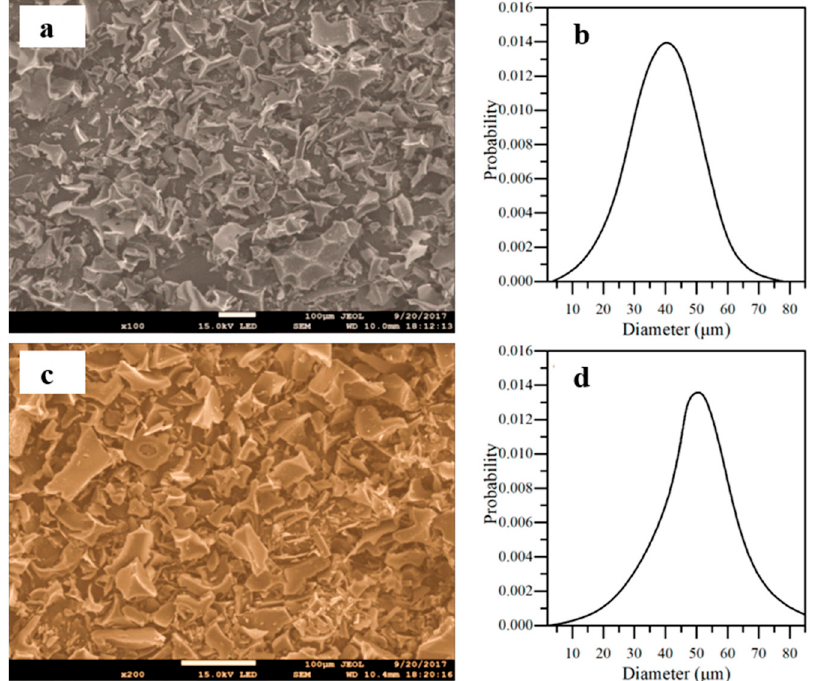
Figure 6. SEM micrograph of synthesized activated carbon (AC) ( a ) and activated carbon modified with 5.0 wt.% of magnetite nanoparticles (ACM) ( c ), and the corresponding particle size probability distribution of synthesized activated carbon (AC) ( b ) and activated carbon modified with 5.0 wt.% of magnetite nanoparticles (ACM) ( d